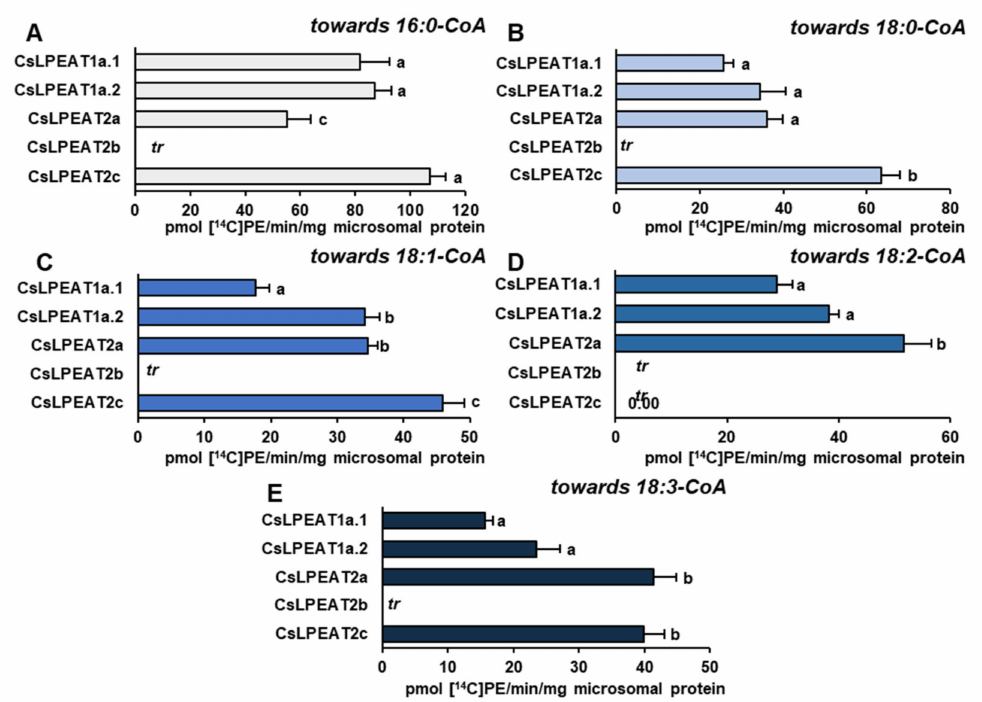
Figure 9. Acyl-CoA specificities of Cs LPEAT isoforms with various acyl-CoA donors and 16:0-LPE as an acyl acceptor, in a yeast system: ( A )—towards 16:0-CoA, ( B )—towards 18:0-CoA, ( C )—towards 18:1-CoA, ( D )—towards 18:2-CoA and ( E )—towards 18:3-CoA. Error bars indicate the SD between at least three repeats ( n ≥ 3). Statistical analysis of the difference in activity of each isoforms at various tested temperature were done by one-way ANOVA followed by Tukeys test. Different letters indicate significant difference ( p ≤